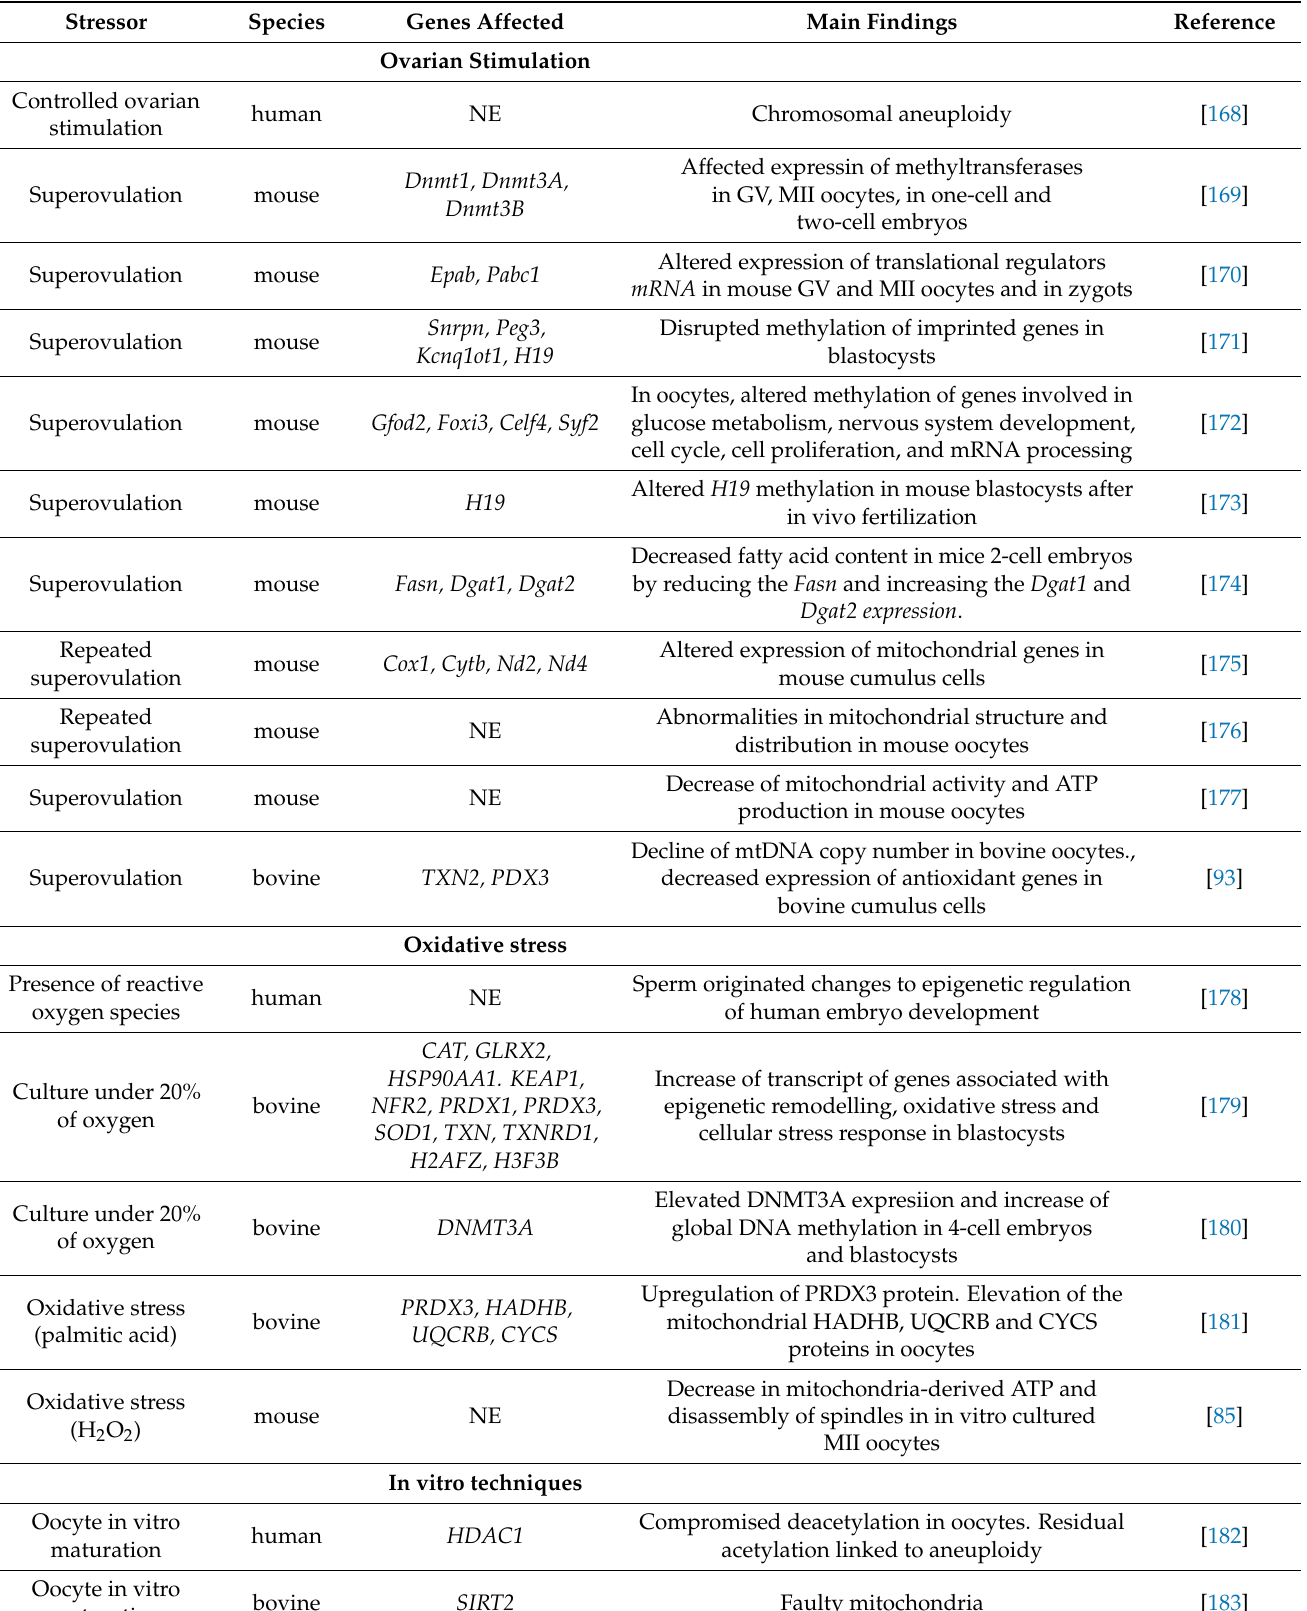
Table 1. Summary of effects induced by ART on epigenetic changes in oocytes, early embryos and their influence on offspring. “NE” indicates specific gene effects were not